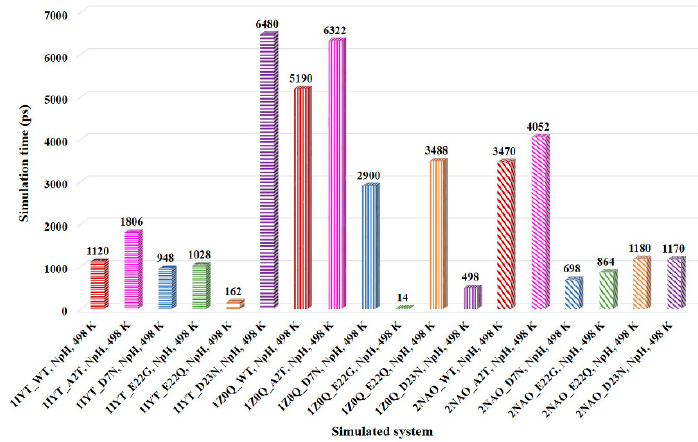
Figure 4. Comparison of the α -strand appearance time in region 24–26 for the simulated systems. WT, A2T, D7N, E22G, E22Q, and D23N systems are represented by red, pink, blue, green, orange, and purple bars, respectively. Except for the systems with A2T mutation and the 1IYT_ D23N system, mutant systems showed an α -strand structure in the shorter simulation time as compared to the WT systems in all the simulated PDBs.